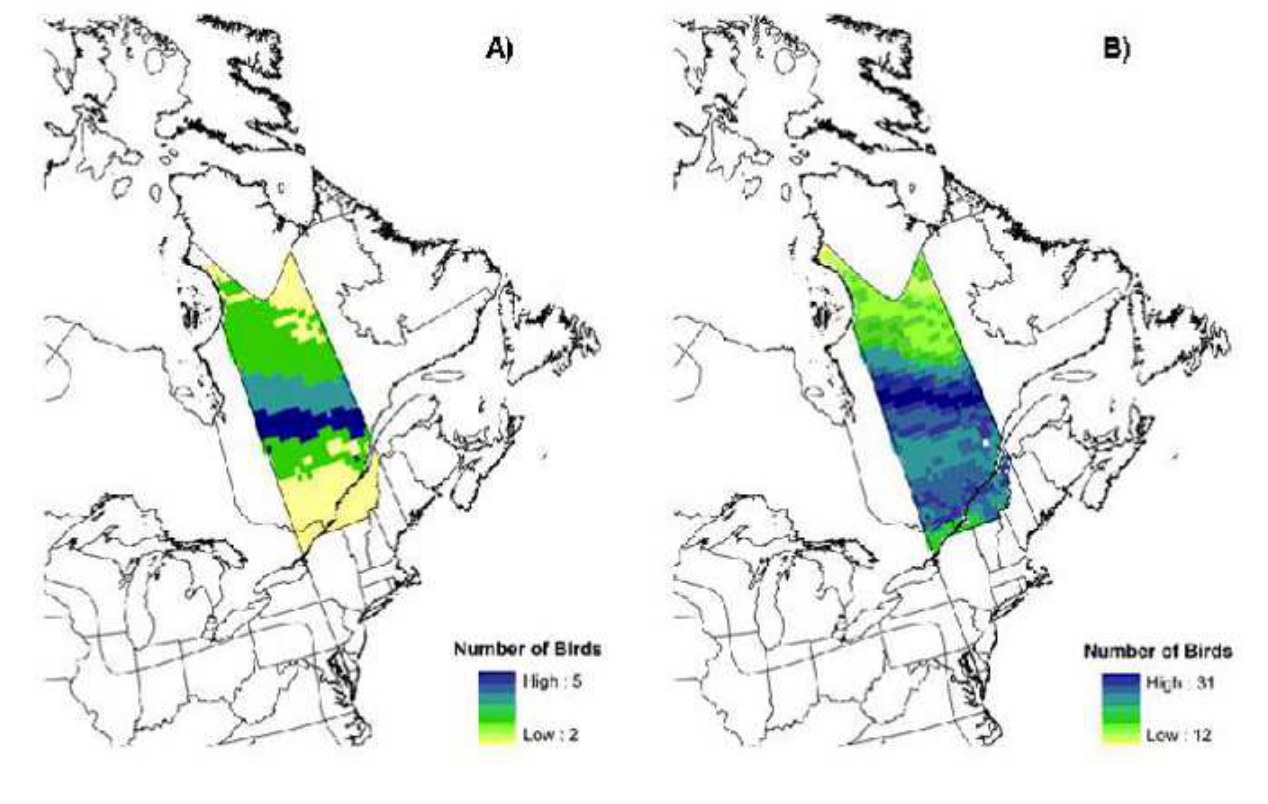
Fig. 3. Probable origins of American Black Ducks ( Anas rubripes ) harvested in the Central breeding/ harvest region during the 2005 hunting season for birds fed in A) agricultural areas ( n = 5) and B) in nonagricultural areas ( n = 49). A likelihood based assignment was used to place individuals to geographic origins on the basis of stable hydrogen isotope values (see Methods). The results displayed represent the sum of assignments across the samples (see